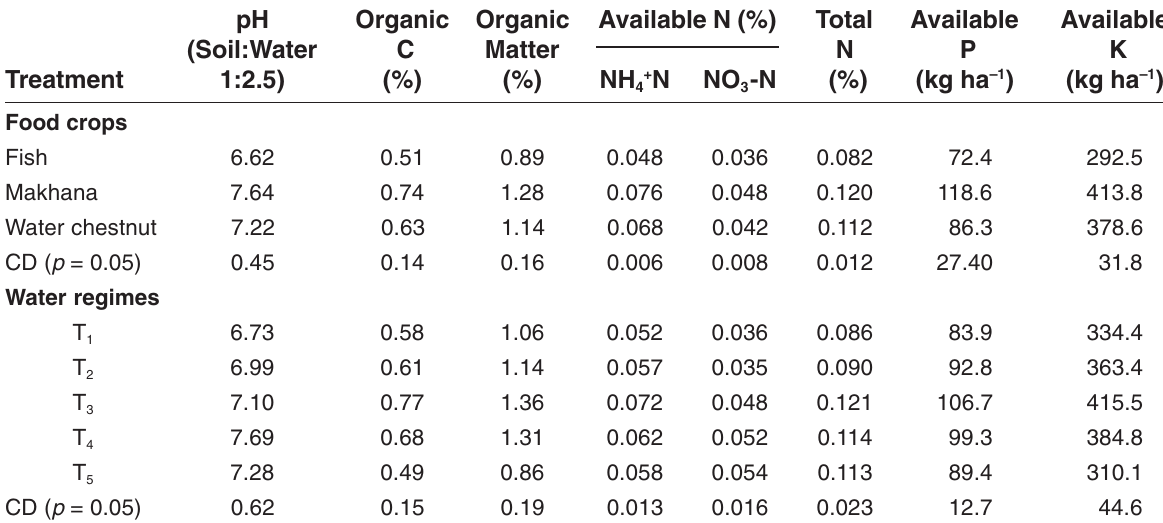
Soil Fertility Status as Influenced by Pisciculture and Aquatic Food Crops Under Varying Water Regimes pH Organic